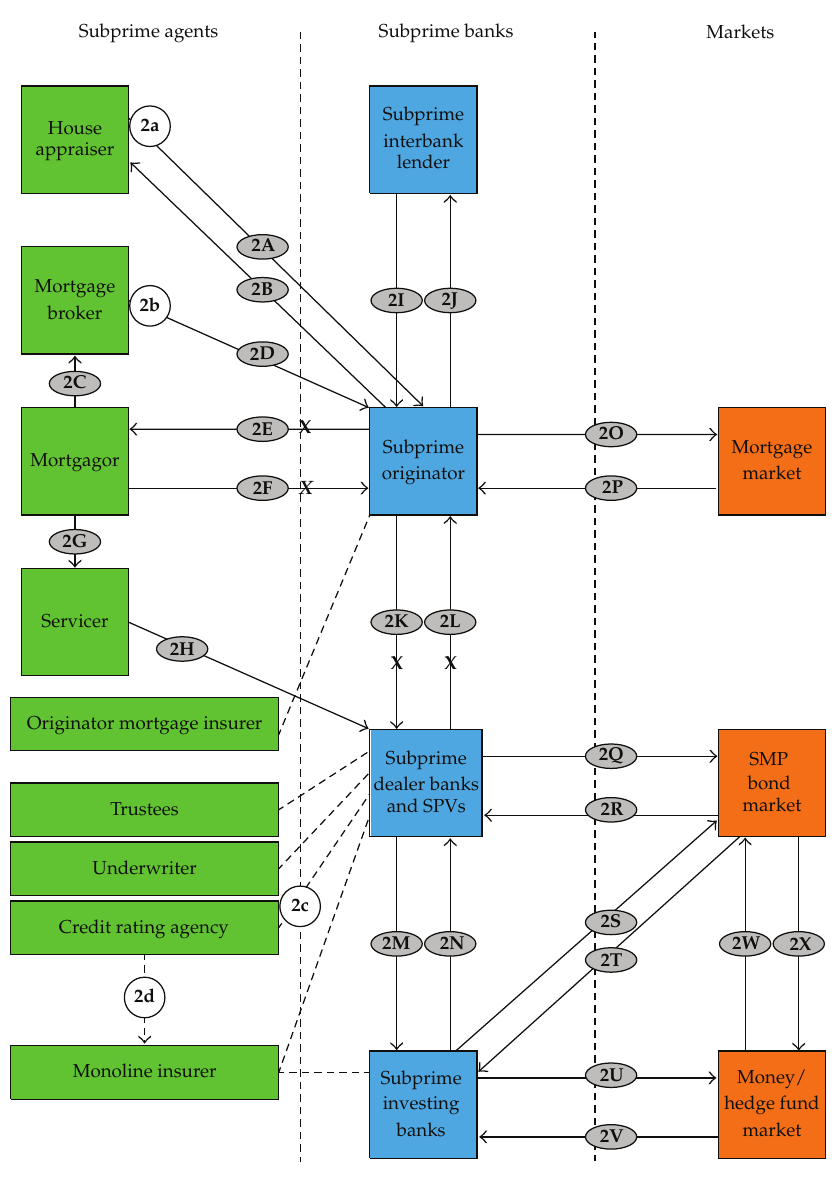
Figure 2: A subprime mortgage model with